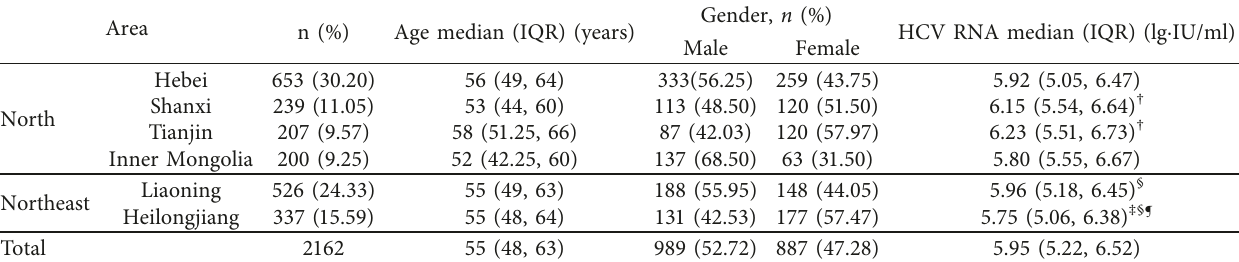
Table 1: Demographic and virological characteristics of HCV-infected patients in North and Northeast China.